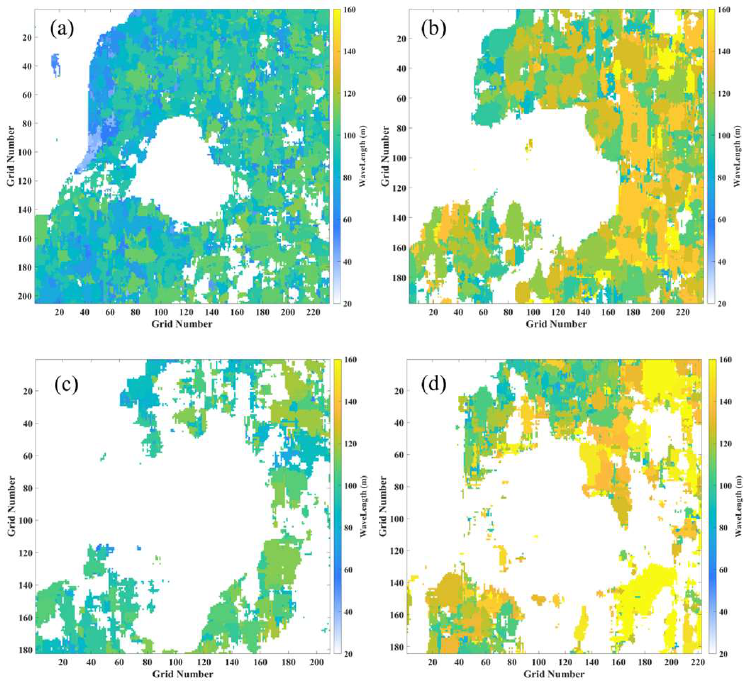
Figure 5. The wavelength results. The blank areas are land or wavelengths greater than the wavelength maximum. ( a ) GF ‐ 3, ( b ) Sentinel ‐ 1, ( c ) ALOS PALSAR, ( d ) ENVISAT ASAR.